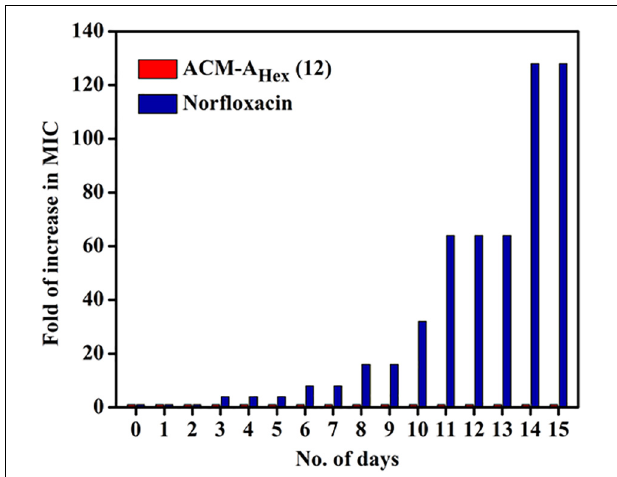
FIGURE 8 | Propensity of resistance development of MRSA ATCC33591 against ACM-A Hex ( 12 ) and Norfloxacin. In each passage, MIC was performed in triplicate and reproducible experimental results were obtained ( p = 0.0147, Student’s t -test with Welch’s